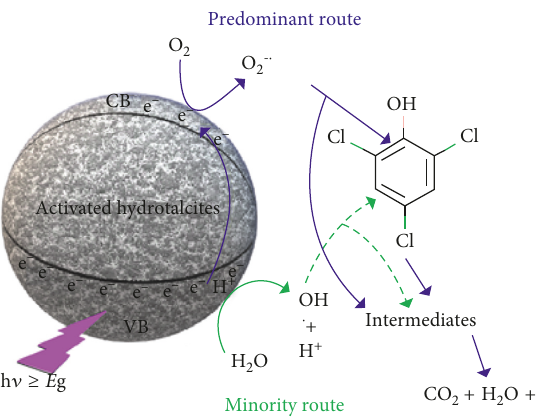
Figure 16: Possible routes for the degradation/mineralization of 2,4,6-trichlorophenol by activated